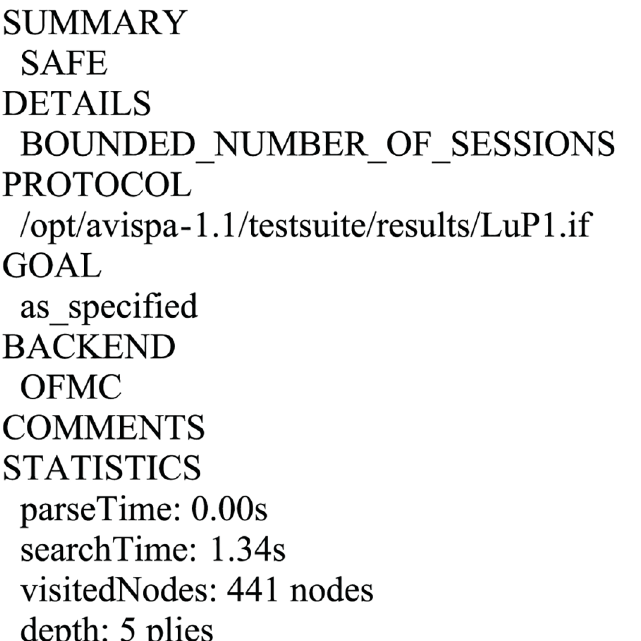
Fig 3. Simulation result for the OFMC.